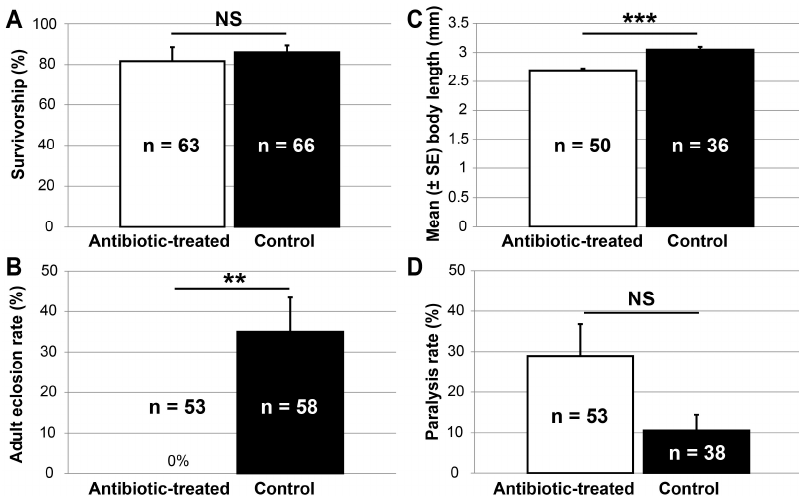
Figure 2. Impacts of 10-day exposure to the antibiotic-treated and the control diet (corn juice) on the mean (± SE) Blissus insularis survivorship ( A ), adult eclosion rate ( B ), body length ( C ), and paralysis rate at 24-h exposure to bifenthrin ( D ). The number in each bar indicates the total number of B. insularis fifth instars that were subjected to each treatment. NS, no significant difference ( α = 0.05); ** p < 0.01; *** p < 0.001.